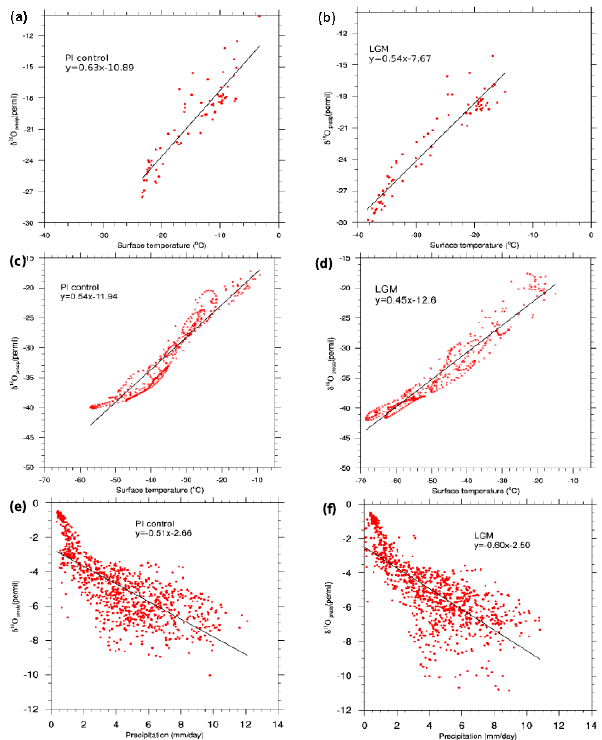
Fig. 6. The relationship between δ 18 O precip (‰) and surface tem- perature ( ◦ C) is shown for Greenland ( a and b ) and Antarctica ( c and d ). The relationship between δ 18 O precip (‰) and precipitation (mmday − 1 ) is shown for the tropics ( e and f ). Left panels: PI con- trol simulation, right panels: LGM-combined